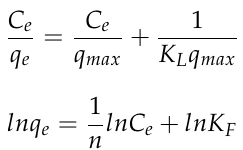
with one layer and three layers of